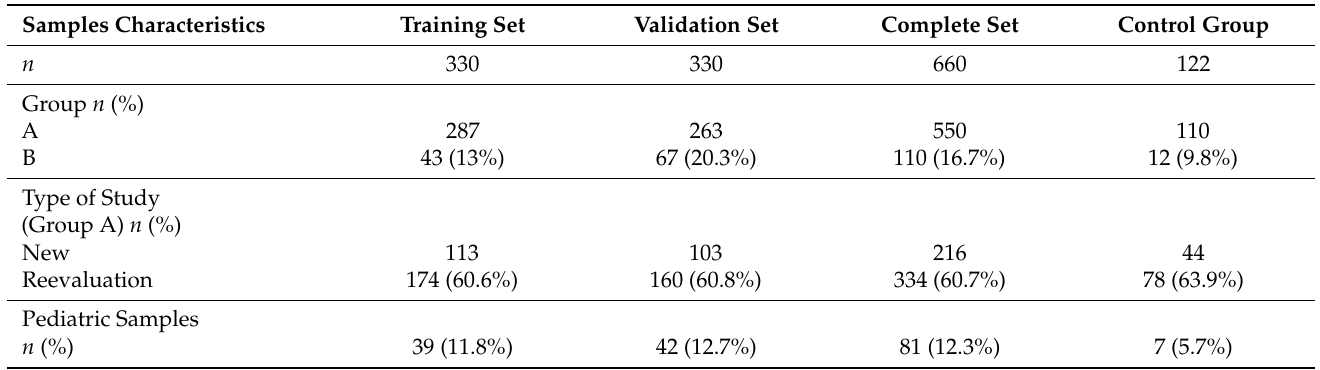
Table 2. Characteristics of the samples.